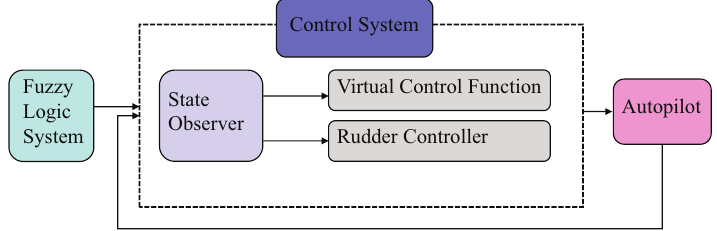
Figure 1. The flowchart of the sequence of steps of the proposed